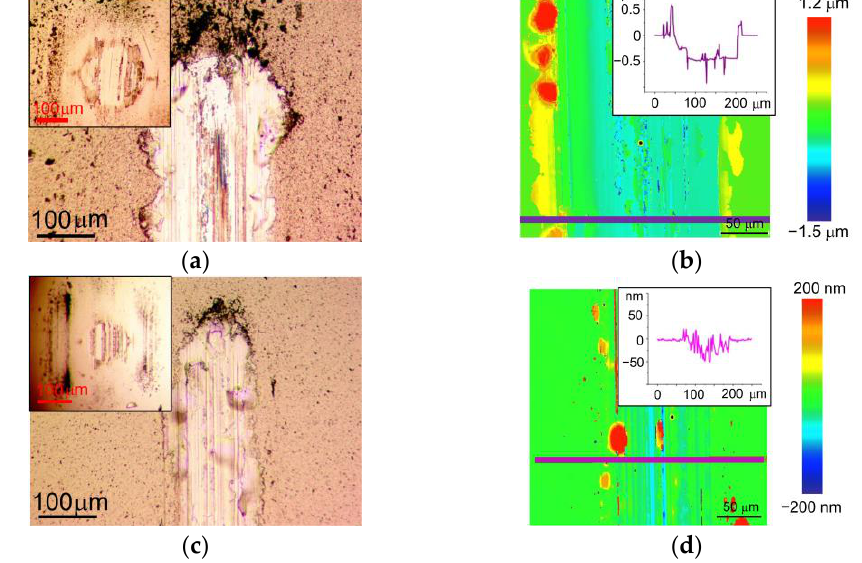
Figure 10. Wear of the ( a , b ) WSe x /NP-W and ( c , d ) WSe x S y /NP-W_3.6 coatings after tribotest in N 2 -enriched environment at a load of 5 N: inserts in ( a , c ) show the wear scars of counter bodies, and the depth profile of the wear tracks are shown in the inserts in ( b , d ).